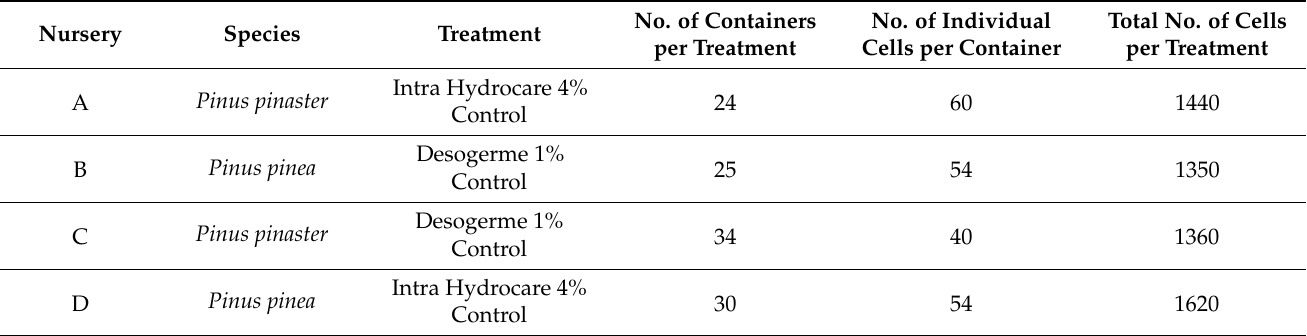
Table 1. Nursery germination assays: treatments and species tested per